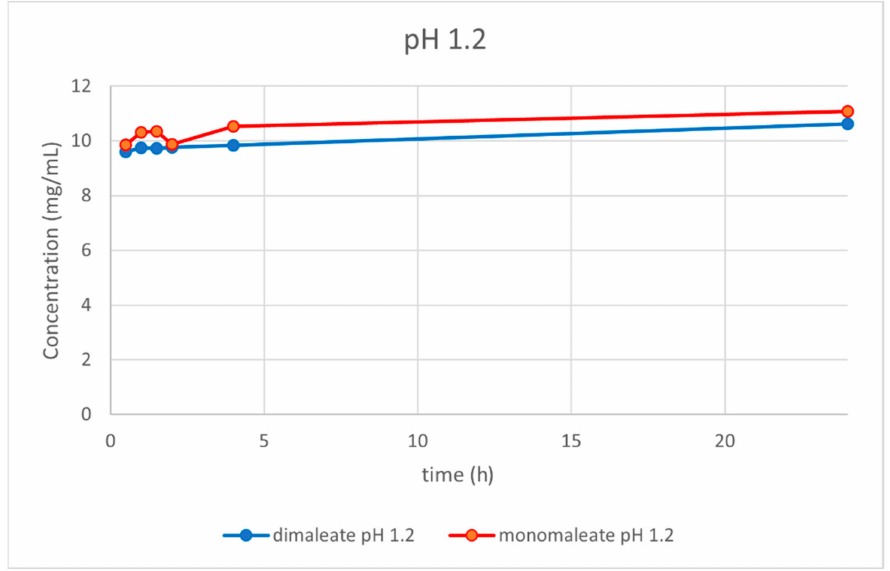
Figure 14. Dissolution testing of glasdegib monomaleate and glasdegib dimaleate at pH =